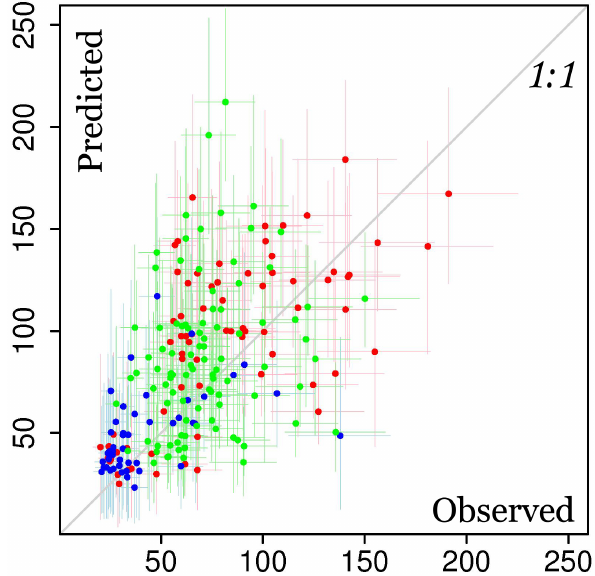
Fig. 10. Observed vs. predicted N ccn (cm − 3 ) for all horizontal tran- sects during westerly flow (blue), northwesterly flow (green), and northerly flow (red). Error bars are defined in the text. The 1:1 relation line is